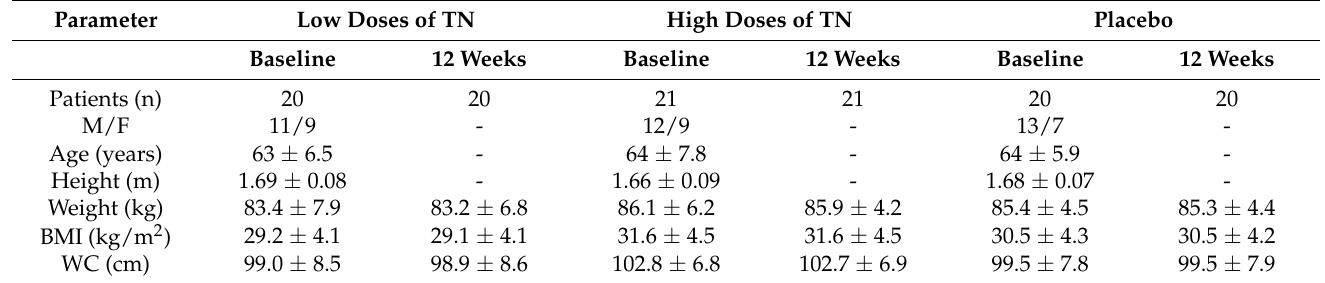
Table 1. Baseline and 3-month general data and anthropometric parameters of randomized subjects in the placebo, high-dose, and low-dose thinned nectarine groups.